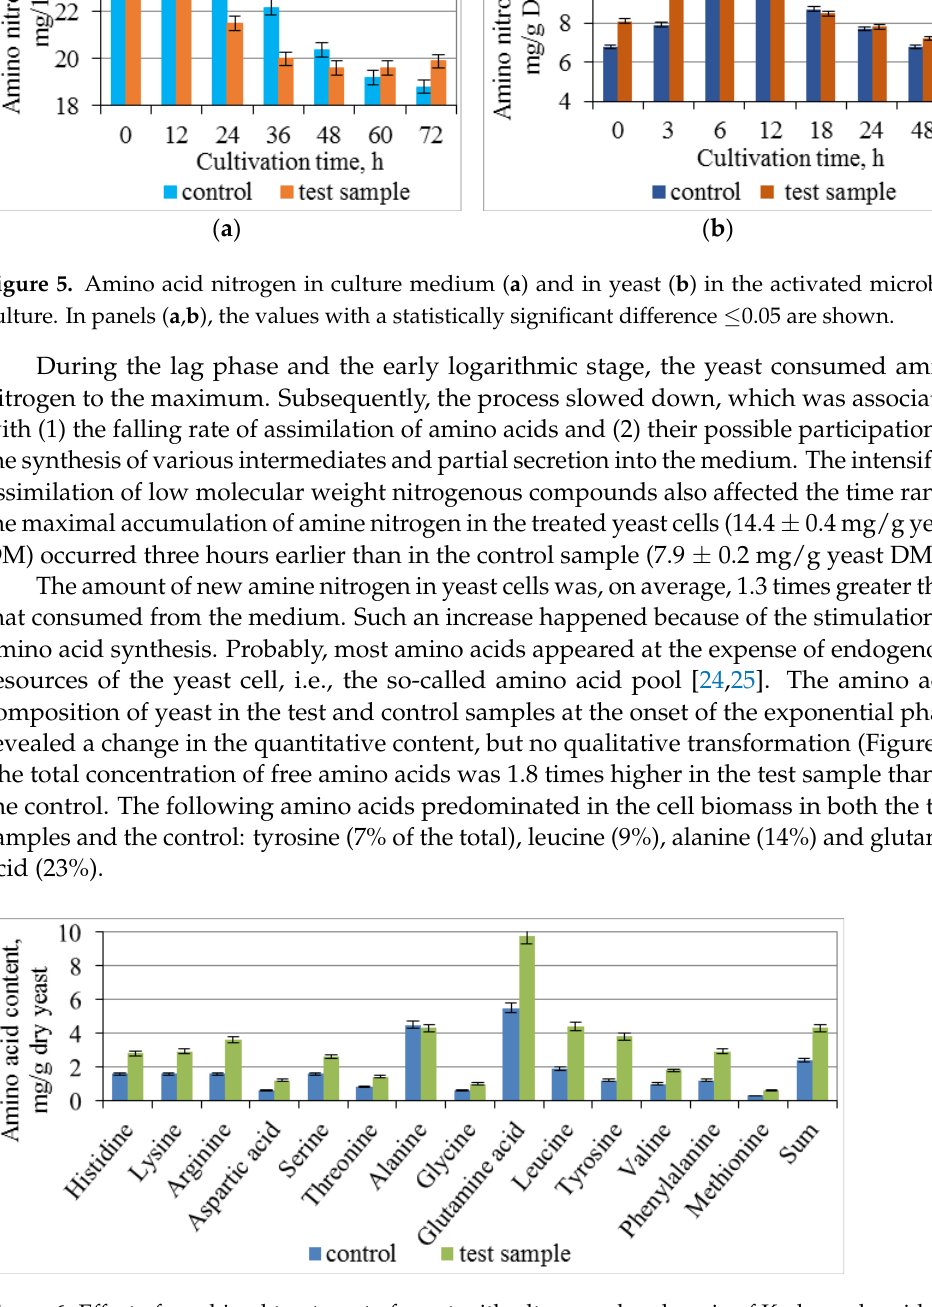
( b ) Figure 7. Amount of protein in yeast during cultivation ( a ) and in the culture medium ( b ). In panels ( a ) and ( b ), the values with a statistically significant difference ≤ 0.05 are shown. The changes in the amount of intracellular protein in all samples during cultivation followed the same pattern. An increase of 39–47% relative to the initial value during the adaptation phase reached its maximum 1–2 h earlier in the test sample than in the control sample (Figure 7, a). We calculated the specific rate of protein biosynthesis in the yeast treated with ultrasound and Krebs cycle acids based on the data illustrated by Figure 7 (a). In the logarithmic growth phase, it was (9.2 ± 0.3) × 10 − 2 h − 1 , which was 1.6 times higher than in the control sample. After this rise, the protein concentration plummeted almost to its initial value. This process was more intense in the test sample. The active consumption of amino nitrogen and the development of new protein obviously hap ‐ pened as a result of the action of the enzymatic system in the yeast cell. Among yeast hydrolases, proteolytic enzymes have a special role in intracellular processes. Their function in the organism is not only a destructive one, but also regulatory [24]. Table 3 shows the changes in the activity of intracellular and extracellular yeast protease that occurred in the test samples and in the control during cultivation.